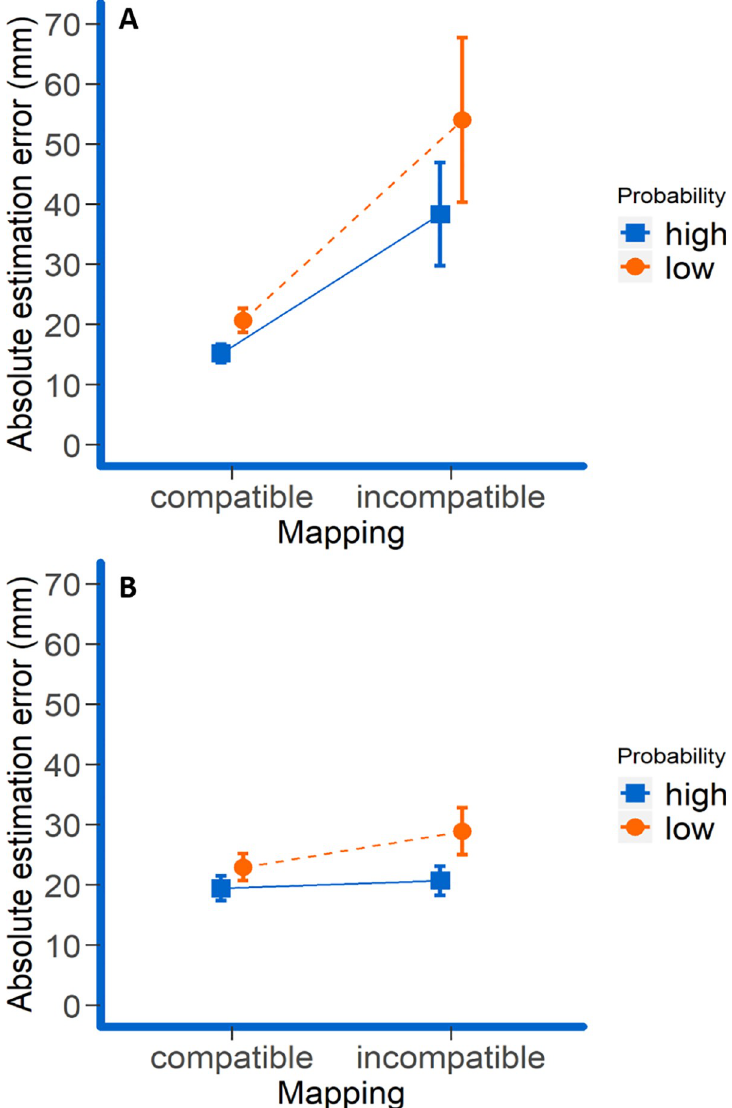
Fig 4. Mean absolute errors as a function of compatibility and frequency of the judgment split up for stylus judgments (A) and cursor judgments (B). Error bars represent 95% paired-difference confidence intervals [26].